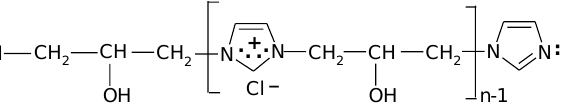
Figure 6. Proposed chemical structure of [IME] + Cl − (where: n =